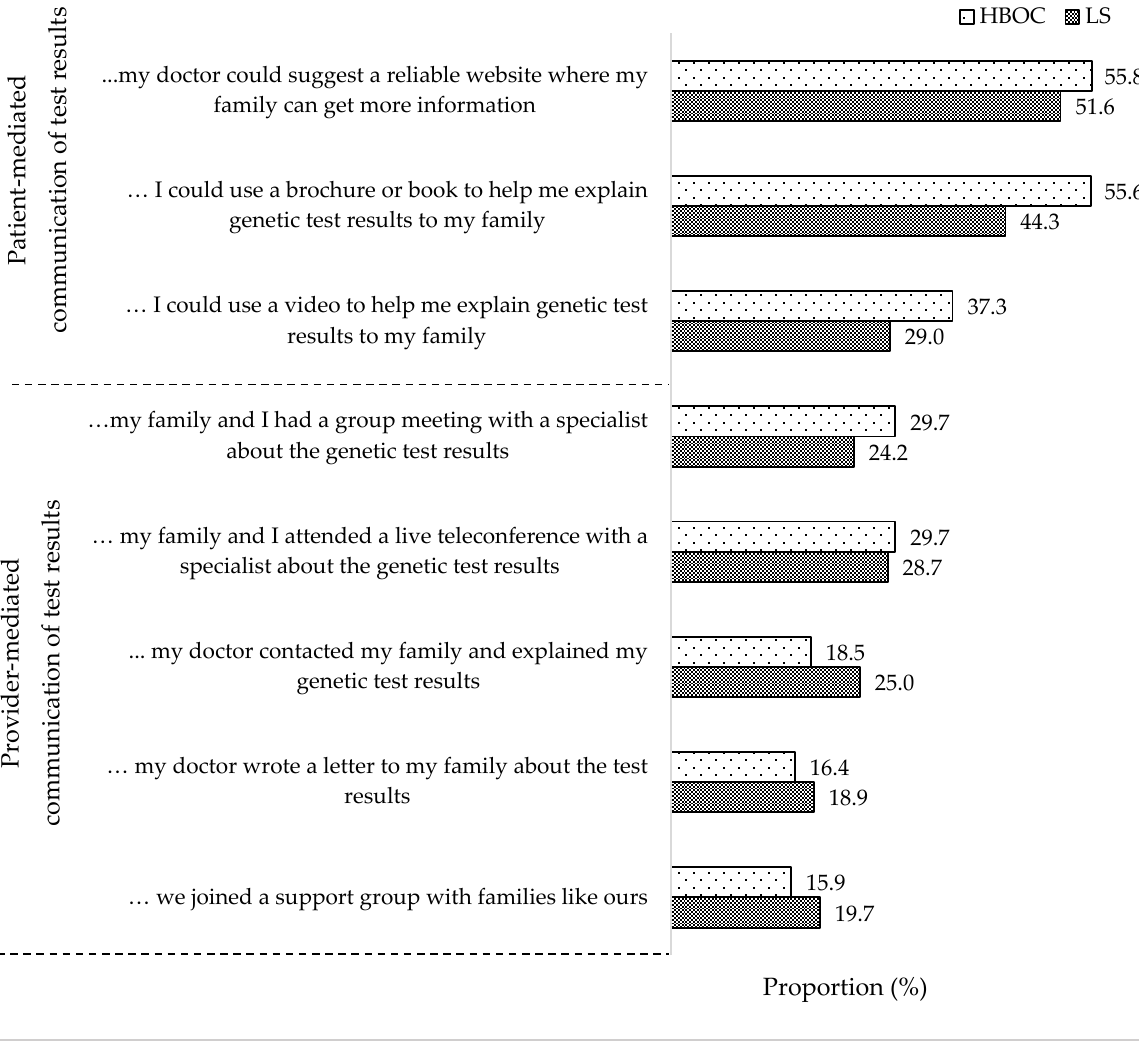
Figure 2. Preferences for provider involvement in family communication of test results for all carriers of familial pathogenic variants (index cases + relatives n = 358).